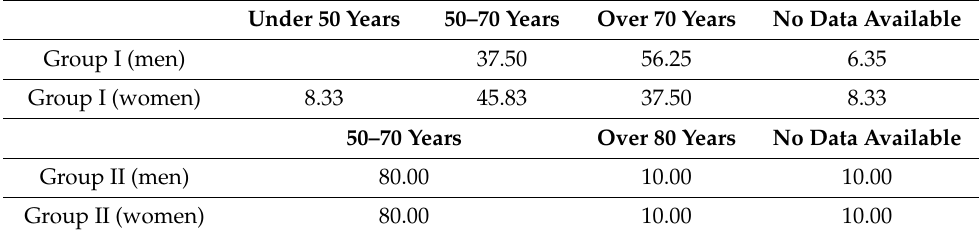
Table 2. Literacy of the presenters (data are presented in